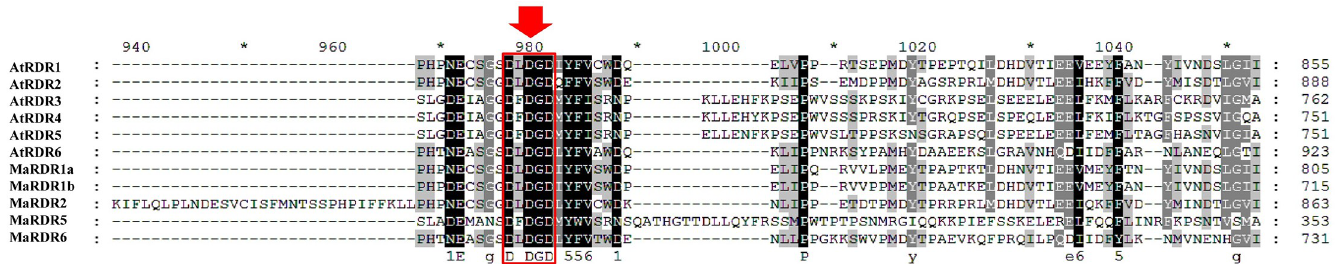
Fig 4. RdRP conserved domain of the aa sequences of M . acuminata and Arabidopsis RDR proteins by Clustal-W program in MEGA 11. The conserved DxDGD catalytic motif are surrounded by the red box.